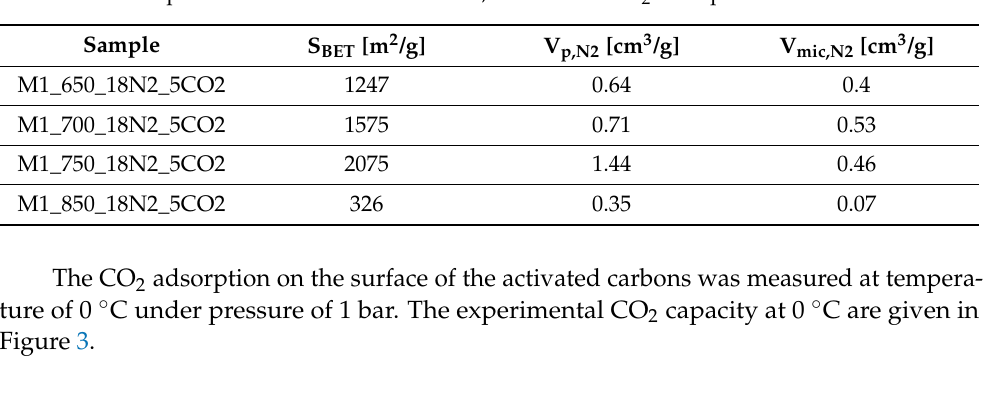
Figure 2. The pores size distribution of the activated carbons, N 2 adsorption at − 196 °C.